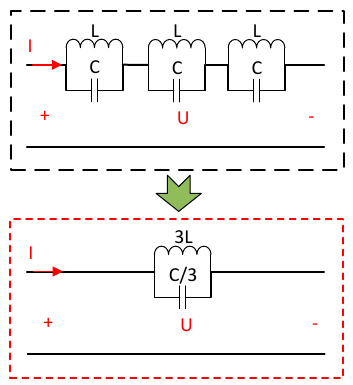
Figure 3. The equivalent circuits of the three-DGS model in Figure 2c.